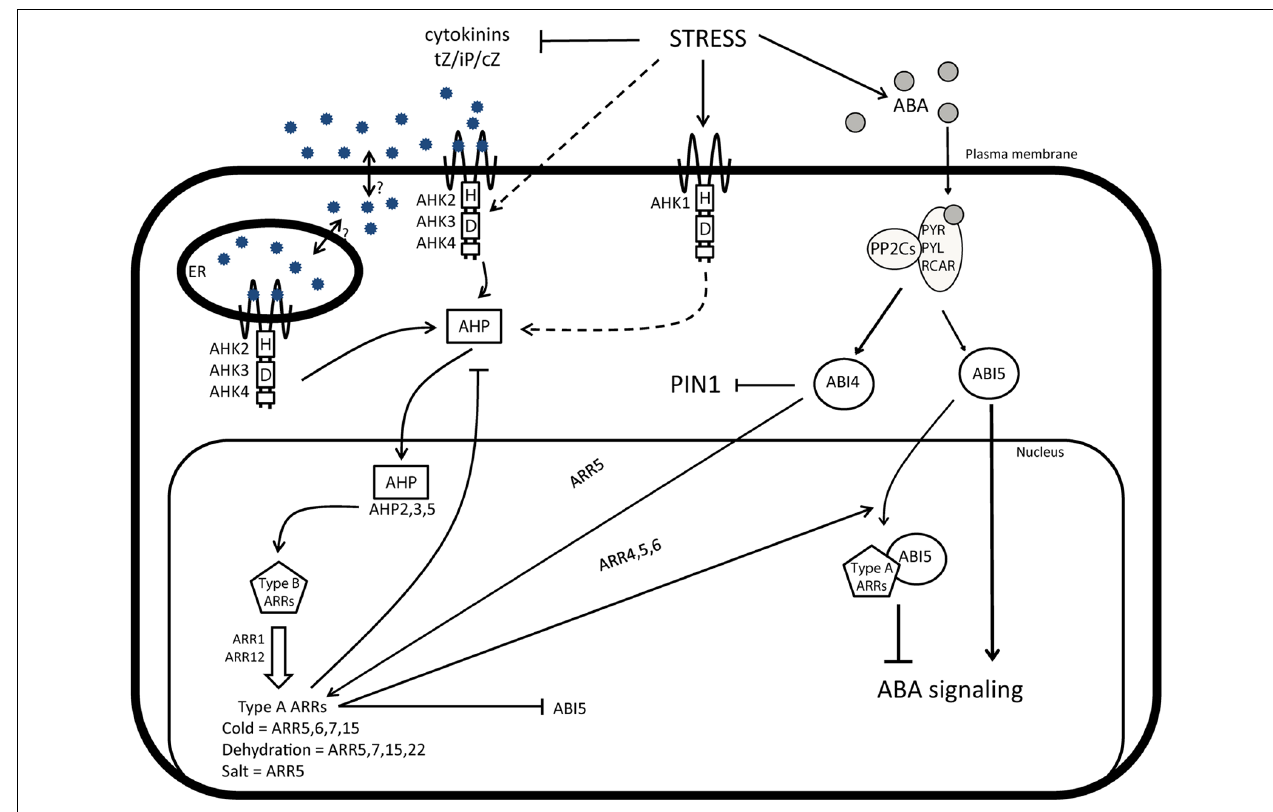
receptors PYR/PYL/RCAR promotes the interaction with PP2C proteins that will activate downstream responses through signaling components including ABI5 and ABI4. At the same time, ABA interferes with the activity of CK and auxin and via ABI4 attenuates the expression of the PIN1 auxin efflux carrier and enhances the transcription of the CK signaling repressor ARR5 . Interestingly, type-A ARRs, such as ARR5, are upregulated, despite the low CK levels, probably because of the indirect activation of the CK signaling pathway by alternative receptors of the histidine kinase family, such as